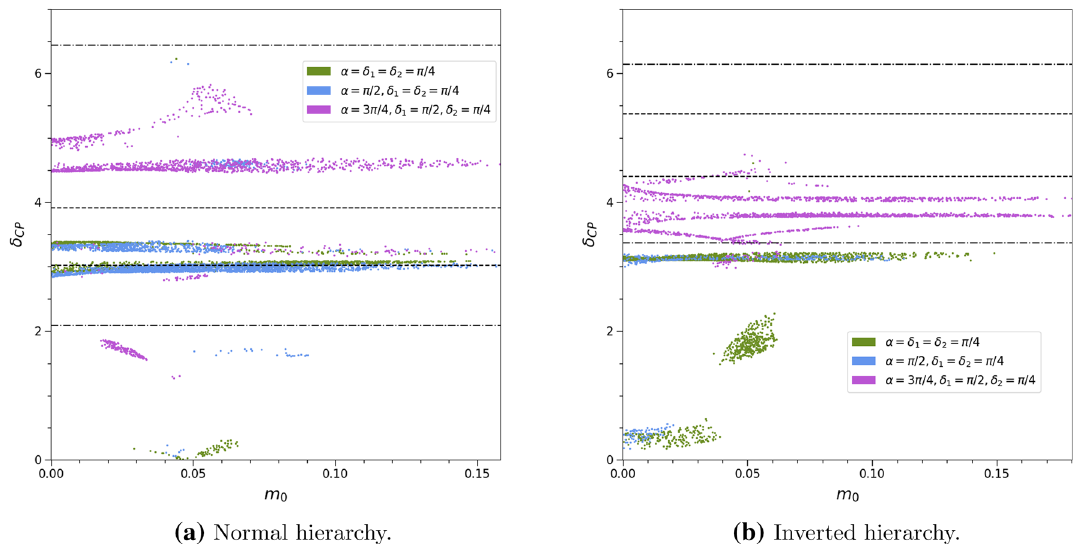
Fig. 7 Predictions for the Dirac phase δ CP , for the normal ( a ) and inverted ( b ) hierarchies, in three scenarios of non-zero Majorana phases. As before, the horizontal dashed and dashdotted lines indicate the 1 σ and 3 σ current intervals for the Dirac CP phase δ CP ,